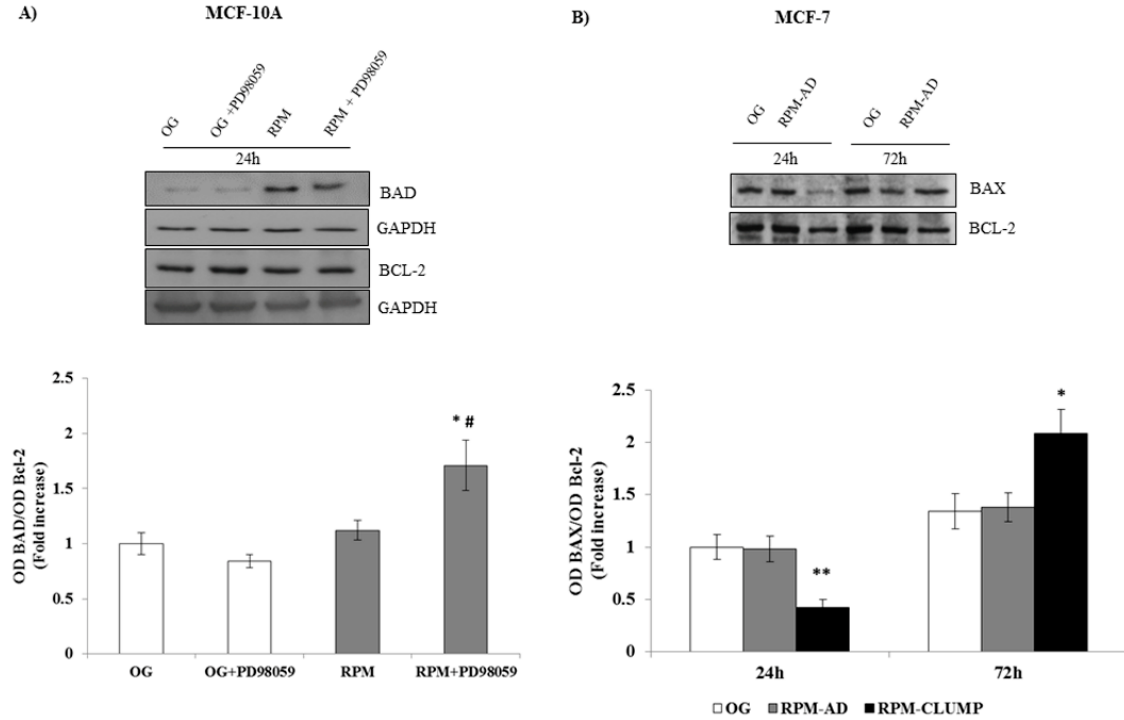
Figure 15. Immunoblot bar chart showing the expression of the Bad/Bcl-2 ratio w/o the p-ERK inhibitor, PD89059, in MCF-10A ( A ) and the Bax/Bcl-2 ratio MCF-7 ( B ) in on-ground control cells, RPM adherent cells, and RPM cell clumps at 24 h. In MCF-10A, columns and bars represent densitometric quantification of the optical density (OD) of a specific protein signal normalized with the OD values of the GAPDH serving as the loading control. In MCF-7, Bax and Bcl-2 were blotted onto the same membrane; thus, Bcl-2 was used as the loading control. Each column represents the mean value ± SD of three independent experiments. In MCF-10A, * p < 0.05 vs. OG; # p < 0.05 vs. RPM by ANOVA followed by Bonferroni post-test. In MCF-7, * p < 0.05, ** p < 0.01 vs. OG e vs. RPM-AD by ANOVA followed by Bonferroni post-test.